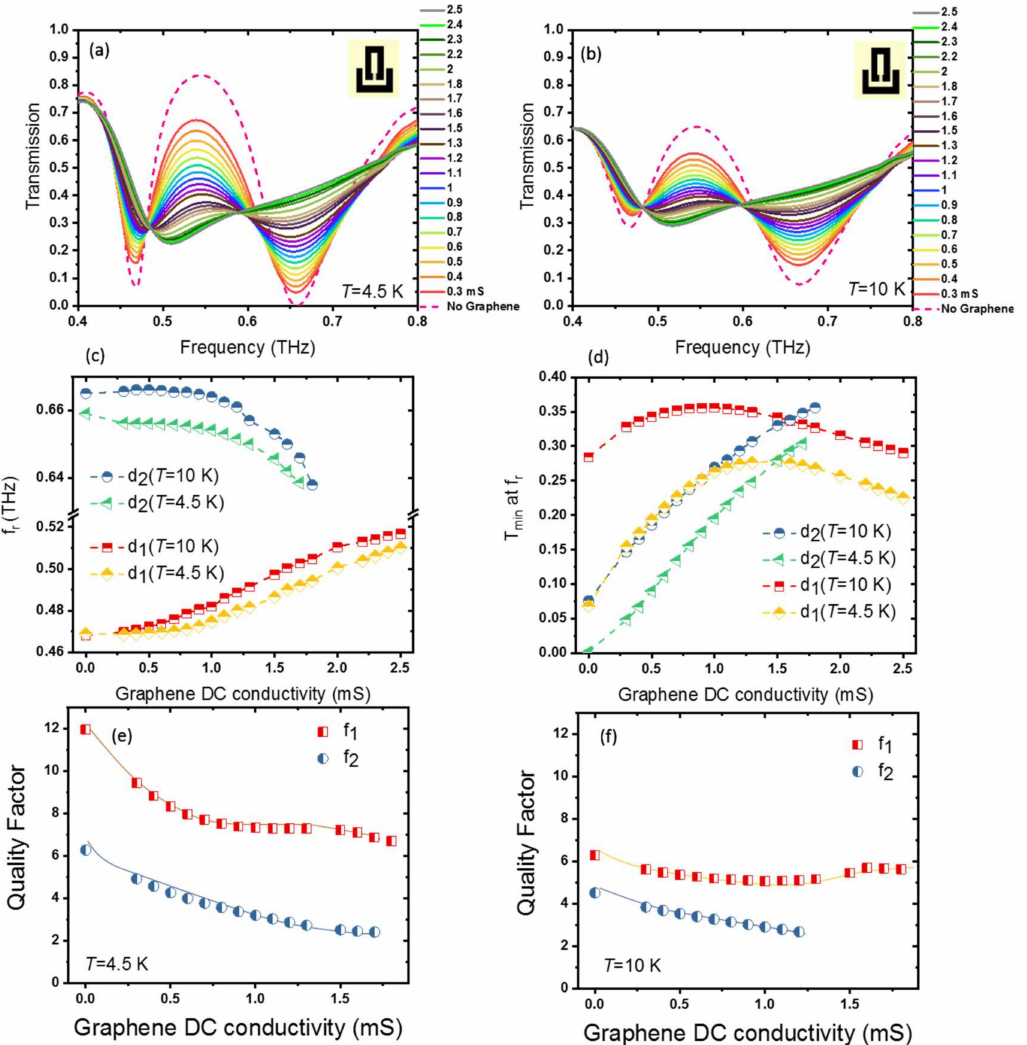
Figure 5. THz transmission of the metamaterial photonic integrated circuit with hybrid graphene-Nb SRRs for different graphene conductivities: ( a ) at T = 4.5 K, far from the Nb superconducting transition temperature T c , where Nb is in the superconducting quantum phase, and ( b ) at T = 10 K, where Nb is no longer in the superconducting quantum phase. ( c ) Resonance frequencies and ( d ) transmission dips at resonance frequencies of the metamaterial integrated circuit, as a function of graphene’s conductivity at T = 4.5 K and T = 10 K. ( e ) Quality factor at resonance frequencies at T = 4.5 K and ( f ) quality factor at resonance frequencies at T = 10